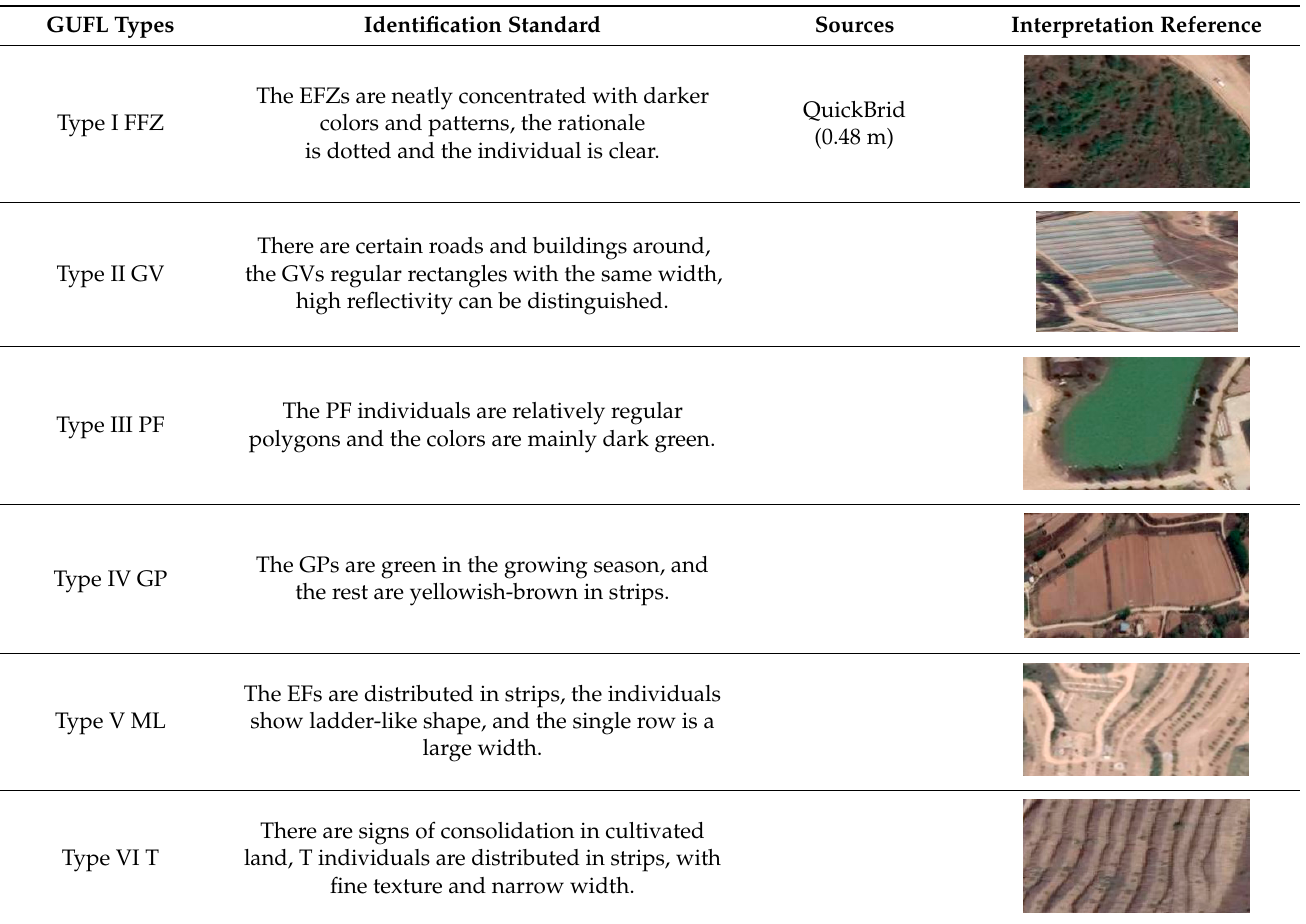
Figure 4. Gully farmland landscape in loess hilly and gully region. Table 1. Reference standards of GUFL types.